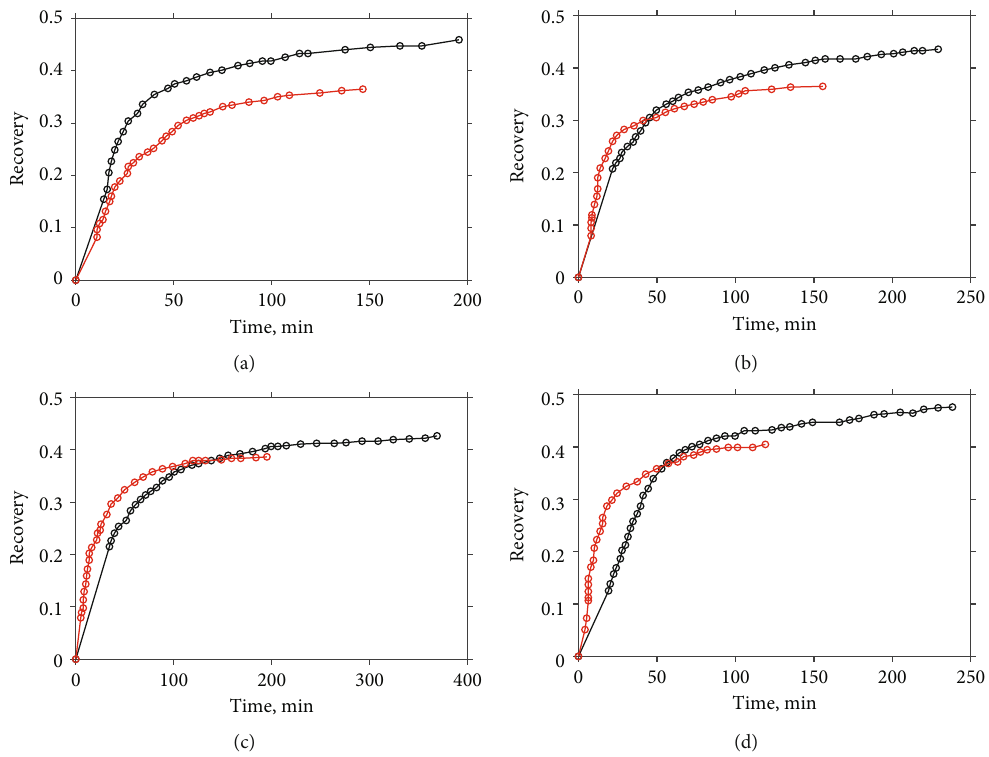
Figure 6: Oil recovery with respect to water fl ooding time before and after the construction of fracture in the experimental core. The red and black points represent the results before and after the construction of fracture. (a) Cores H1-5. (b) Cores H11. (c) Cores H13. (d) Cores H2-12.